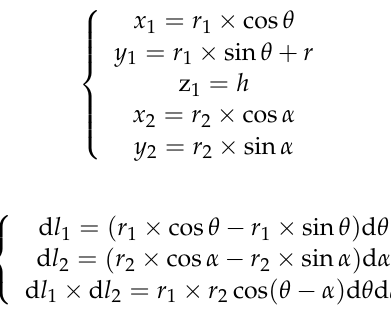
Figure 2. One active to receiver charging mode.